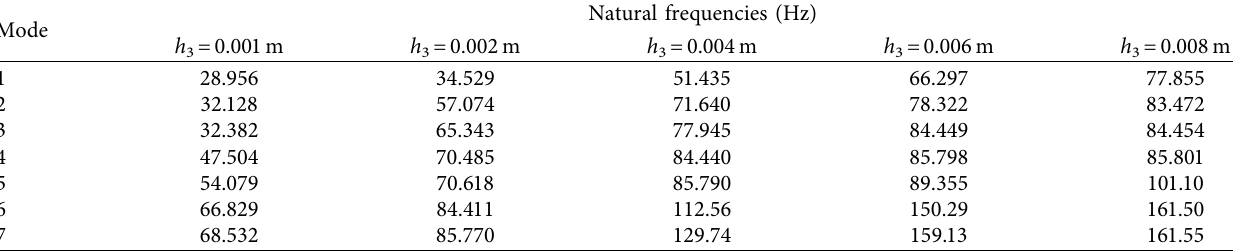
Table 3: First seven natural frequencies of the stiffened double panel-cavity coupled system with the different thickness of the stiffener. Mode